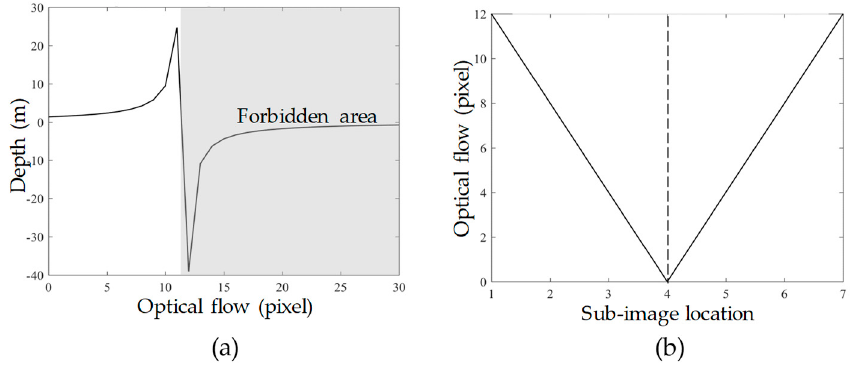
Figure 3. ( a ) Extracted depth of center sub-image with seventh sub-image (among seven sub-images) according to optical flow ( b ) Maximum optical flow on location of sub-image (among seven sub- images).